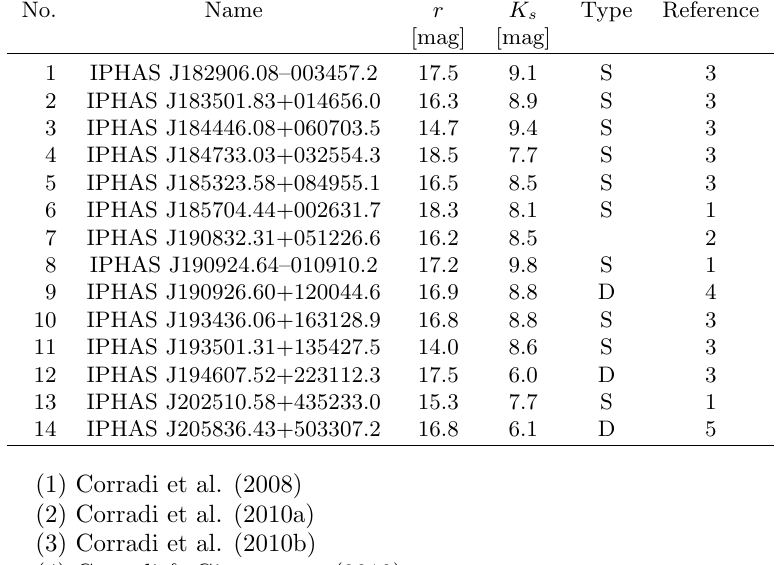
Table 1. List of new symbiotic stars discovered by IPHAS to August 2011. The IAU-registered IPHAS name contains the J2000 coordinates of the